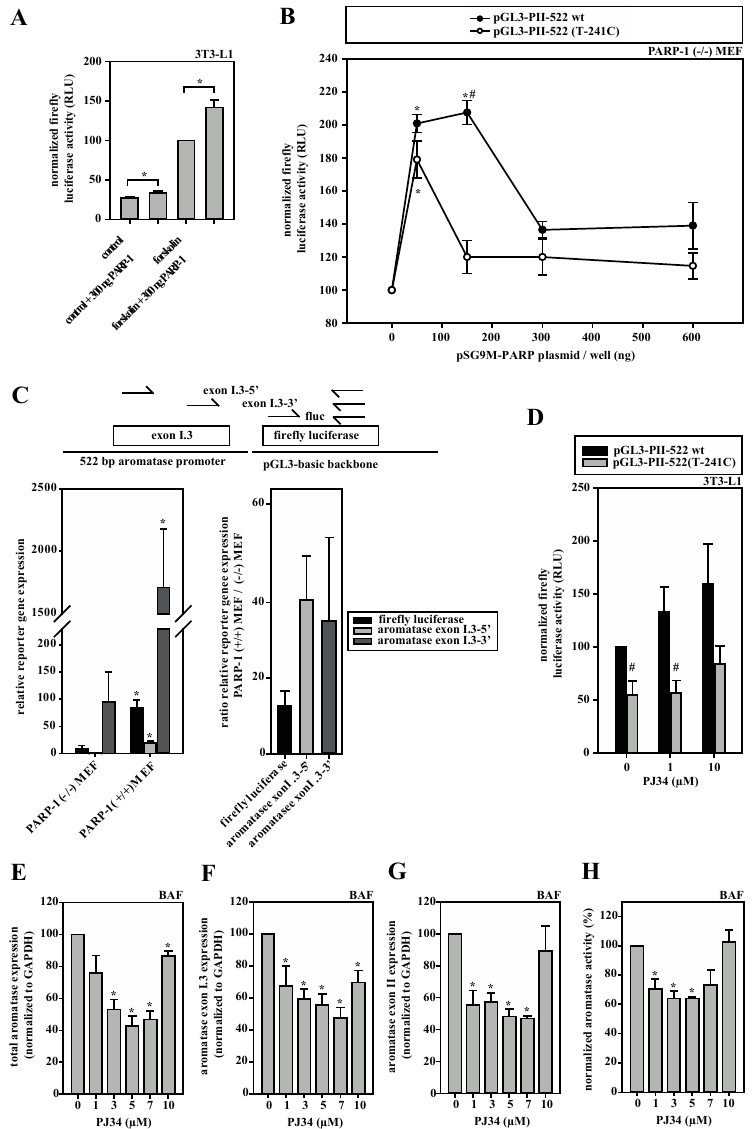
Figure 4. SNV-dependent aromatase expression depends on PARP-1 activity. ( A ) 3T3-L1 cells were transfected with aromatase promoter I.3/II-containing pGL3-PII-522 wt firefly luciferase reporter-plasmids and pRL-SV40. PARP-1 overexpression with 300 ng pSG9M-PARP-1 plasmid increased luciferase activity (PARP-1; n = 8; * p < 0.05). ( B ) PARP-1 ( − / − ) MEFs were transfected with pGL3-PII-522 wt or SNV-containing pGL3-PII-522(T-241C) plasmid. PARP-1 overexpression by co-transfection with pSG9M-PARP-1 resulted in biphasic responses of luciferase activities ( n = 8; * p < 0.05; PARP-1 overexpression versus 0 ng; # p < 0.05 wt versus SNV-containing plasmid). ( C ) PARP-1( − / − ) and PARP-1( +/+ ) MEFs were transfected with pGL3-PII-522 wt plasmids. Aromatase promoter usage on plasmids was measured by qRT-PCR (amplicons are indicated in the scheme; fluc, firefly luciferase), which was normalized to plasmid-DNA, measured by qPCR. The expression of luciferase including exon I.3 (5 (cid:48) - and 3 (cid:48) -regions, respectively) was similarly positively a ff ected by PARP-1 expression ( n = 3; * p < 0.05 PARP-1( +/+ ) versus PARP-1( − / − ) MEFs). Right panel depicts expression ratios. ( D ) 3T3-L1 cells were transfected with the indicated plasmids and stimulated with forskolin. PARP-1-inhibition by PJ34 increased luciferase activity only on the wild-type-promoter I.3 / II construct ( n = 6; # p < 0.05 wt versus SNV-containing plasmid). ( E–H ) In forskolin-stimulated BAFs, the expression of ( E ) total aromatase, ( F ) promoter I.3- or ( G ) promoter II-containing transcripts, and ( H ) aromatase enzymatic activity were measured in the presence and absence of the PARP-1 inhibitor PJ34. Similar biphasic dose-response curves were obtained for all parameters ( n = 3; * p < 0.05 versus controls without